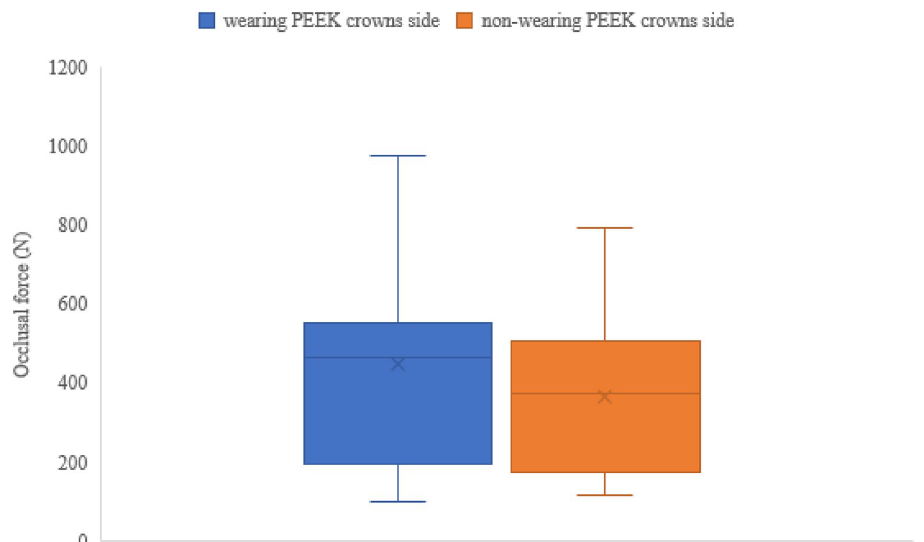
Figure 10. Boxplot of Occlusal force in wearing PEEK crowns side and non-wearing PEEK crowns side. Box; inter quartile range (IQR), Lower whisker; minimum, upper whisker; maximum, Center line; median, cross mark; mean. *Mann–Whitney U test shows no significant difference between PEEK and non-PEEK wearing